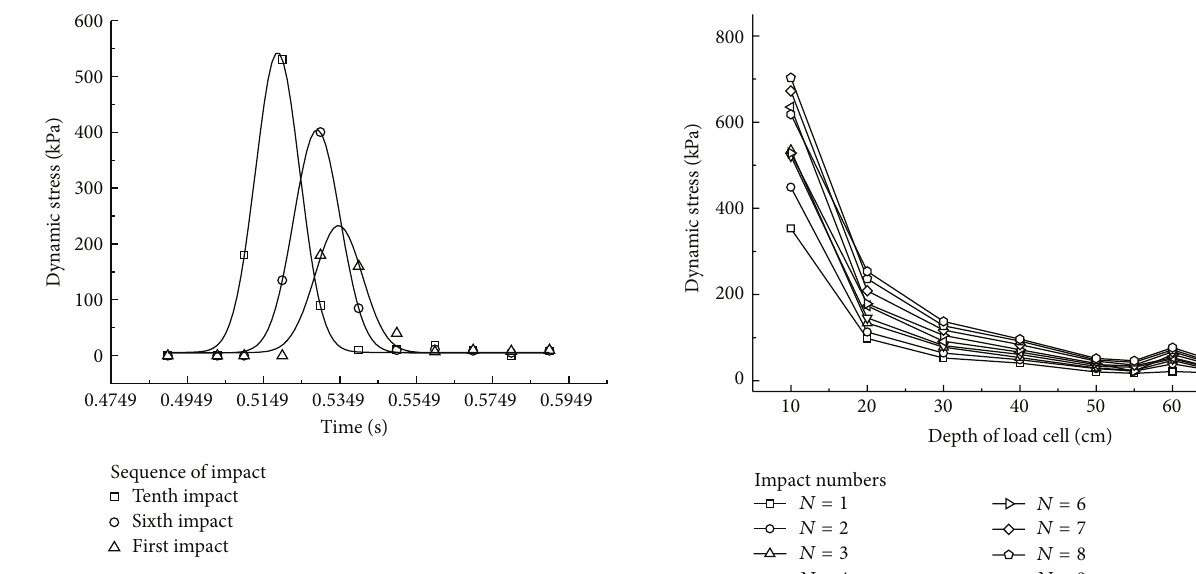
Figure 6: Time history of stress waves under sequence of impact. the interface of the hammer and the hole inward. However, the pores inside the unsaturated soils were discontinuous, and the cross section of impacted hole showed an ellipse shape rather than an idealized circle.